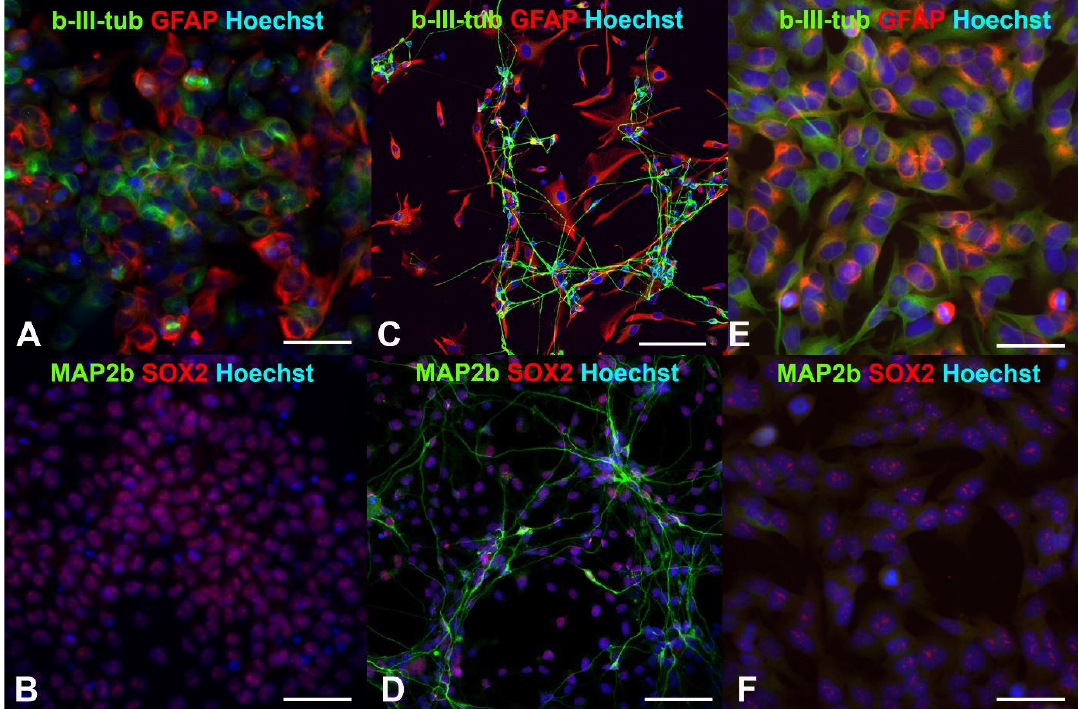
Figure 1. Fluorescent immunocytochemistry of human neural progenitor cells (drNPCs) and human neuroblastoma cells (SK-N-BE (2)): ( A , B ) Phenotype of human drNPC in proliferation medium; ( C , D ) neuronal and glial differentiation of human drNPCs induced by growth factors (positive control); ( E , F ) immunophenotype of human neuroblastoma cells (SK-N-BE (2)). Cells were stained with cocktails of primary antibodies (mouse monoclonal + rabbit polyclonal), followed by staining a cocktail of goat anti-mouse and goat anti-rabbit secondary antibodies with Alexa Fluor 488 (green channel) and Alexa Fluor 633 (red channel), respectively. The cell nuclei were stained with Hoechst (blue channel) in all the images. Scale bar 100 µm for ( A – D ) and 50 µm for ( E , F ). Similar to human neural progenitor cells, human neuroblastoma cells are character-